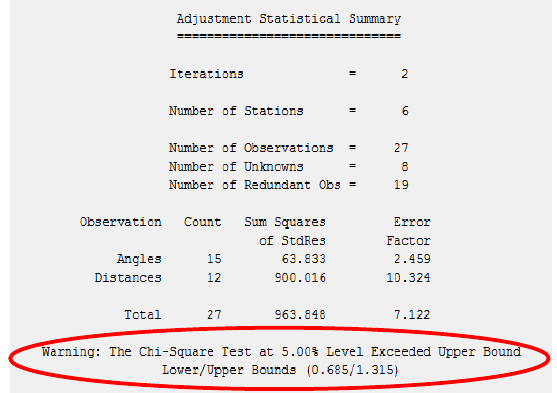
Figure ‎1. Example of a set of measurement data have failed Chi-Square test in StarNet software.